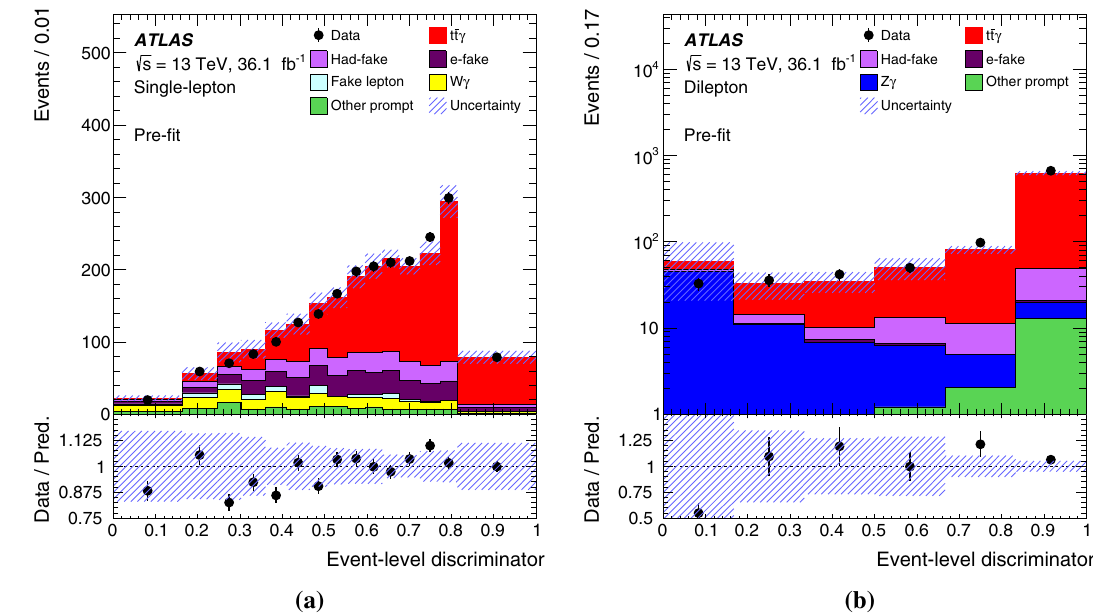
Fig. 4 Distributions of the ELD for the a single-lepton and b dilepton channels after event selection and before likelihood fit. All data-driven corrections and systematic uncertainties are included